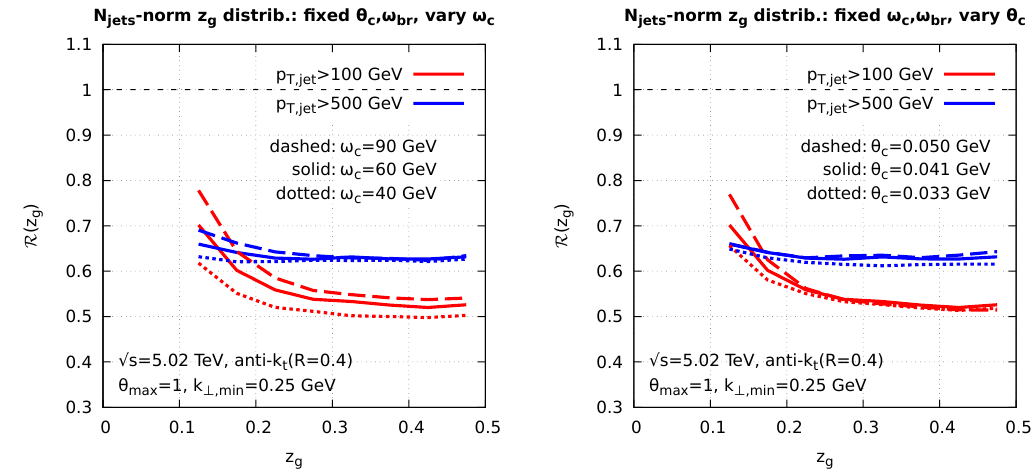
Figure 19 . The e(cid:11)ects of varying ^ q , L and (cid:11) s; med keeping ! br = 3 : 46 GeV (cid:12)xed at its central value (cf. the right plot of (cid:12)gure 6). Left: we vary ! c by (cid:6) 50% at (cid:12)xed (cid:18) c . Right: we vary (cid:18) 2 at (cid:12)xed ! c